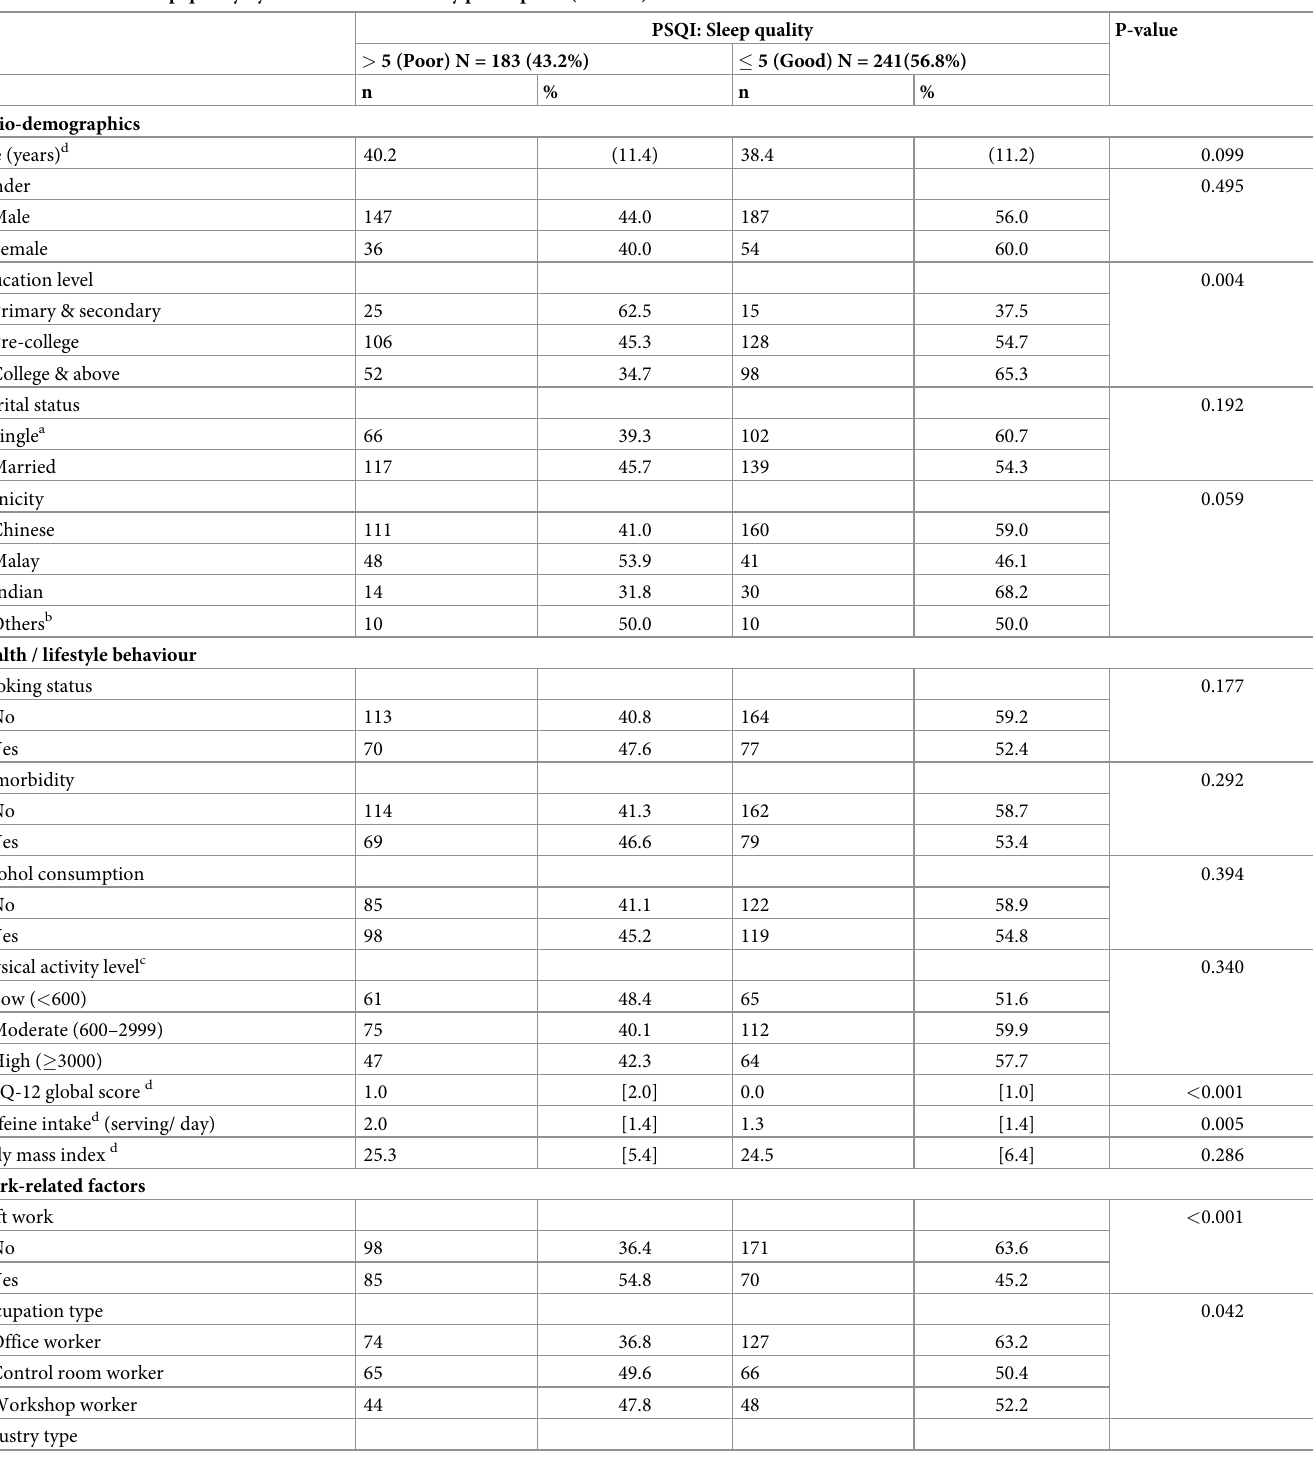
Table 2. Prevalence sleep quality by characteristics of study participants (N =